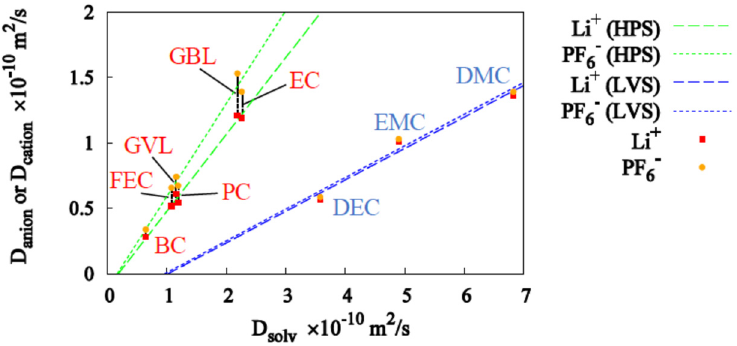
Figure 7. Relationship between 𝐷 (cid:3046)(cid:3042)(cid:3039)(cid:3049) and 𝐷 (cid:3030)(cid:3028)(cid:3047)(cid:3036)(cid:3042)(cid:3041) or 𝐷 (cid:3028)(cid:3041)(cid:3036)(cid:3042)(cid:3041)